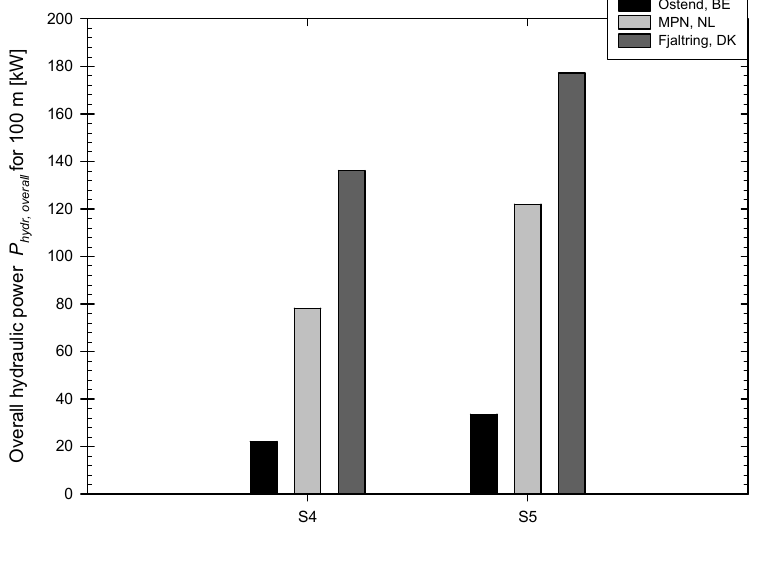
Figure 12. Comparison between overall hydraulic power [kW] gathered over a length of 100 m for scenario 4 and 5 at all three test